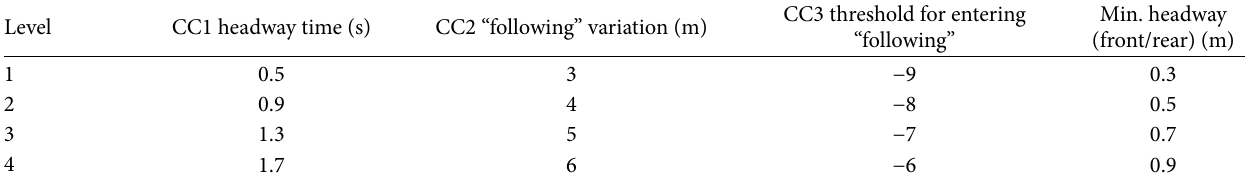
Table 3: Factor level table of the parameters to be